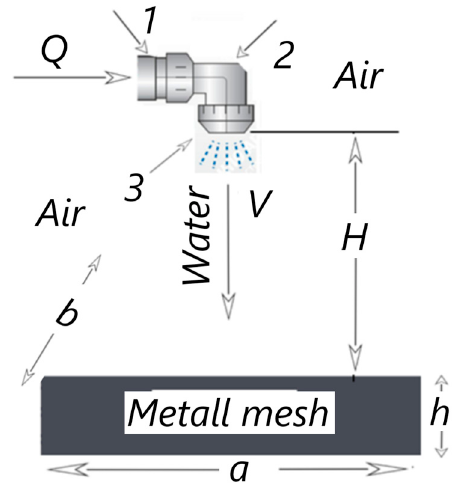
Figure 2. Diagram of the adiabatic cooling process.